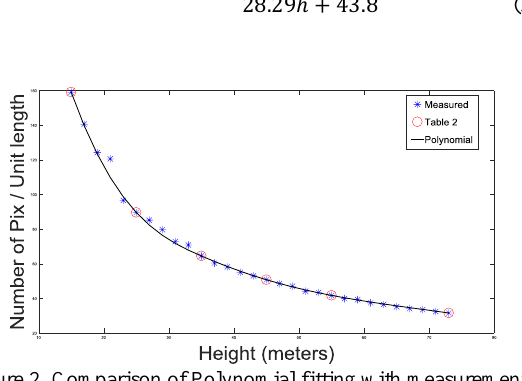
Figure 2. Comparison of Polynomial fitting with